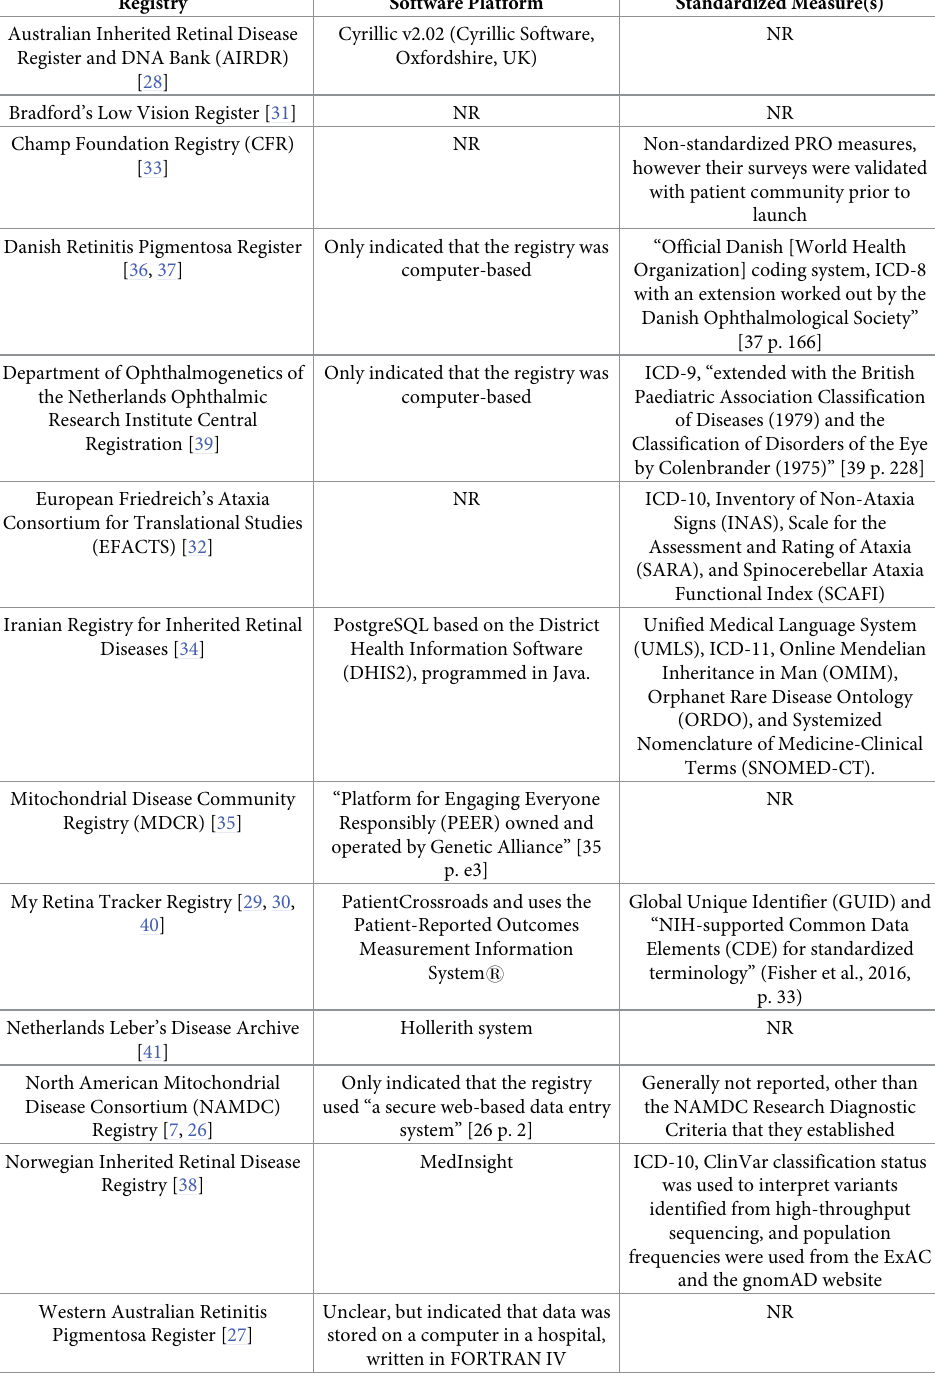
Table 2. Software platforms and standardized measures used by Mitochondrial Disease (MD) patient